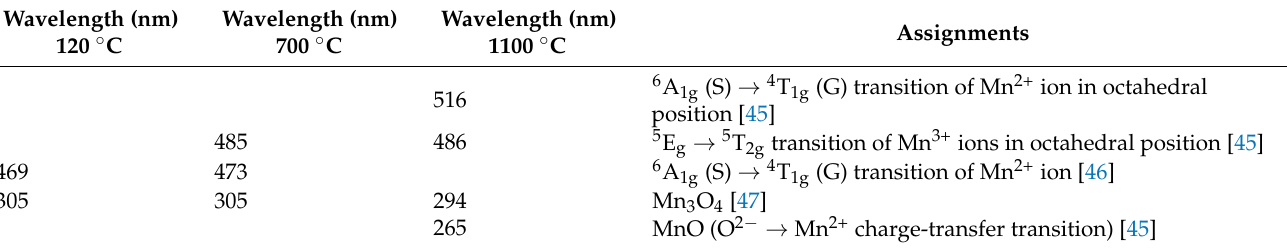
Table 2. Uv-vis bands of the Mn-doped bioactive glass-ceramic as a gel at 120 ◦ C and after treatment at 700 and 1100 ◦